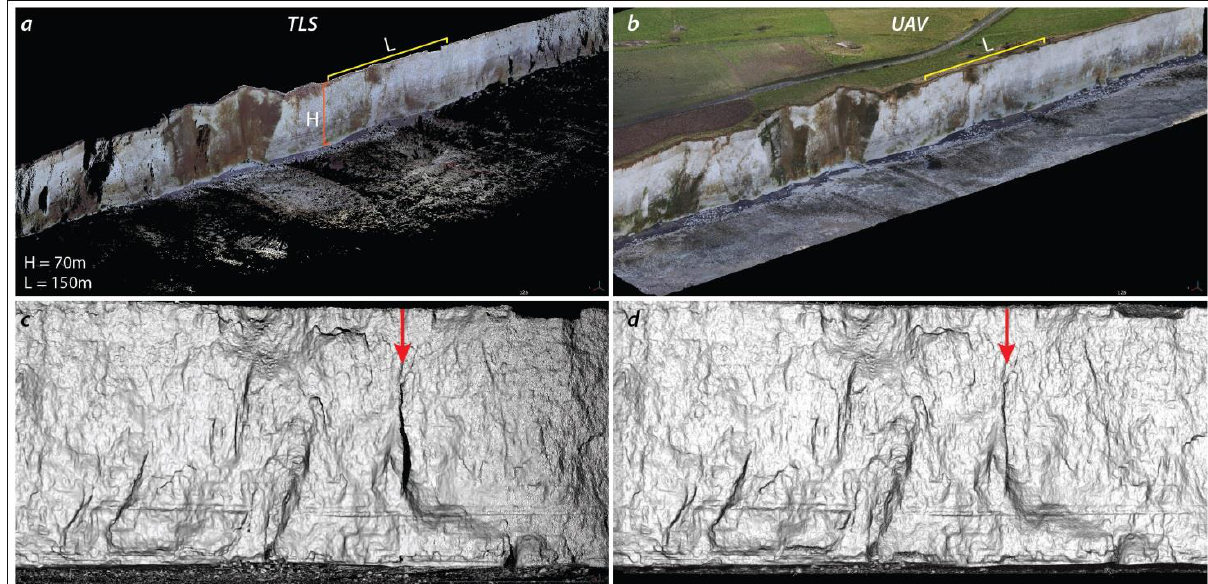
Figure 1 : Comparison of TLS vs UAV topographic coverage. Upper panel: colour point clouds of TLS (a) and UAV (b). Lower panel: topographic gradient of TLS (c) and UAV (d). UAV point cloud not only covers the strict object of interest (cliff face), but also the foreground and hinterland, which both are important to coastal risks managers. On the hinterland, it is possible to assess the amount of residual land that exists between cliff face and exposed assets. On the platform, remainders of cliff collapse lobes informs on the risk of outreach during a